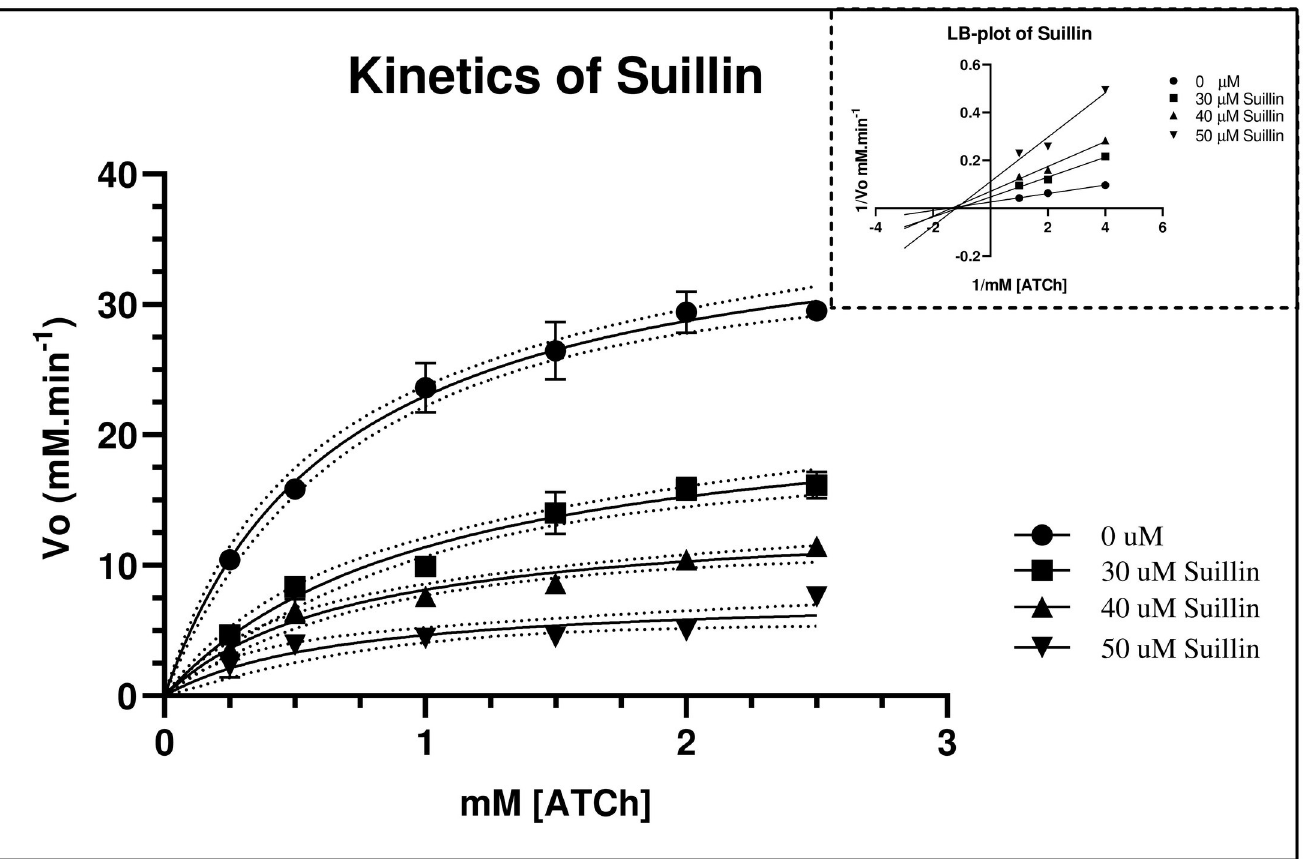
Fig 4. M-M plot showing variation in Vmax for AChE with three different concentrations of suillin. Inset. Lineweaver-Burk plot showing noncompetitive effects exerted by suillin.